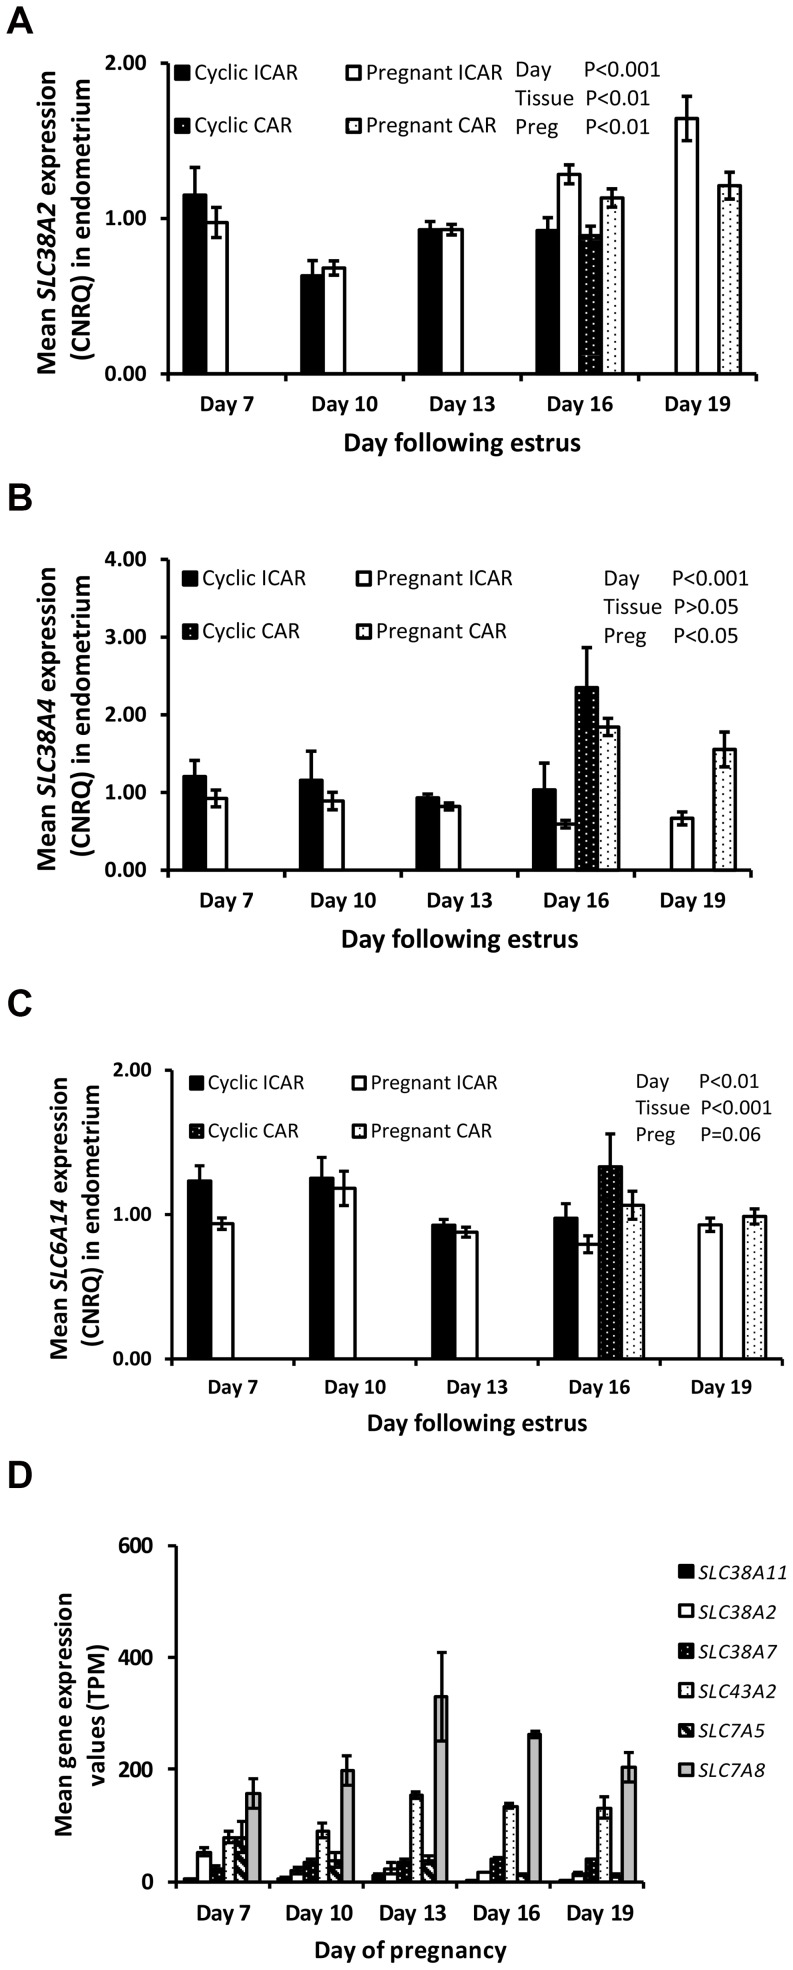
Gene expression values in the endometrium for neutral amino acid transporters as determined by qRT-PCR analysis.Data are displayed as mean calibrated, normalized, relative expression values in arbitrary units (CNRQ ± SEM) in the intercaruncular region of the endometrium from cyclic (solid bars) and pregnant (open bars) heifers and caruncular regions of cyclic (black bars white stipple) and pregnant heifers (while bars black stipple) (n = 5 per treatment per time-point). (A) SLC38A2 expression with a significant effect of day, tissue type and pregnancy status (B) SLC38A4 expression was significantly affected by tissue type and pregnancy status and (C) SLC6A14 whose expression was significantly affected by day, tissue type and pregnancy status. Significance was set at P<0.05. (D) Gene expression values for neutral amino acid transporters in the bovine conceptus during distinct developmental stages. Values were determined by RNA sequencing and are given as mean transcripts per million (TPM ± SEM) with n = 5 per time-point. A significant effect of stage of embryo development was observed for all genes (P<0.05).